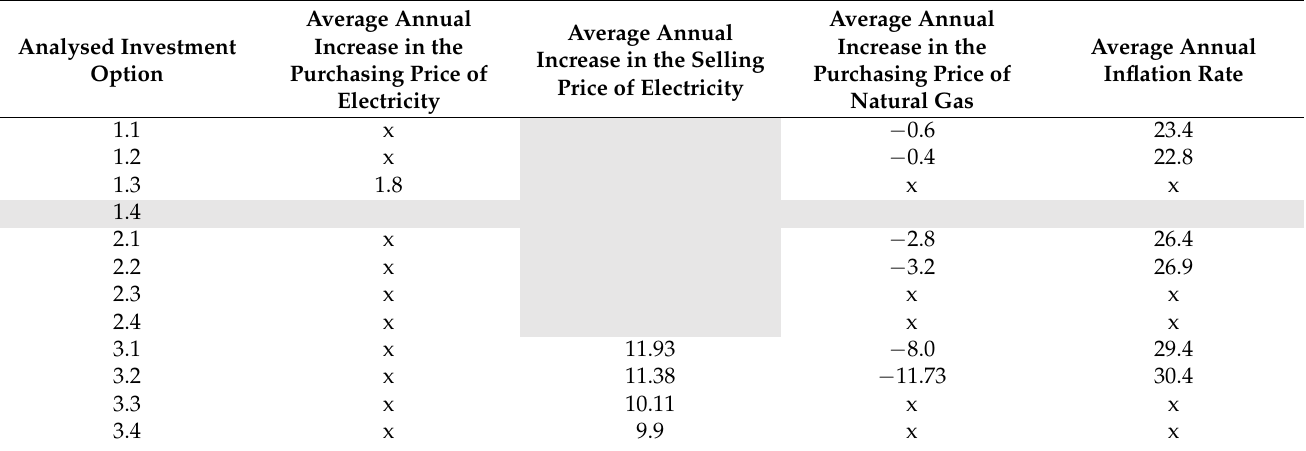
Table 5. Boundary values of the parameters ensuring the NPV values of other investments’ options equal to the NPV value of the solution 1.4